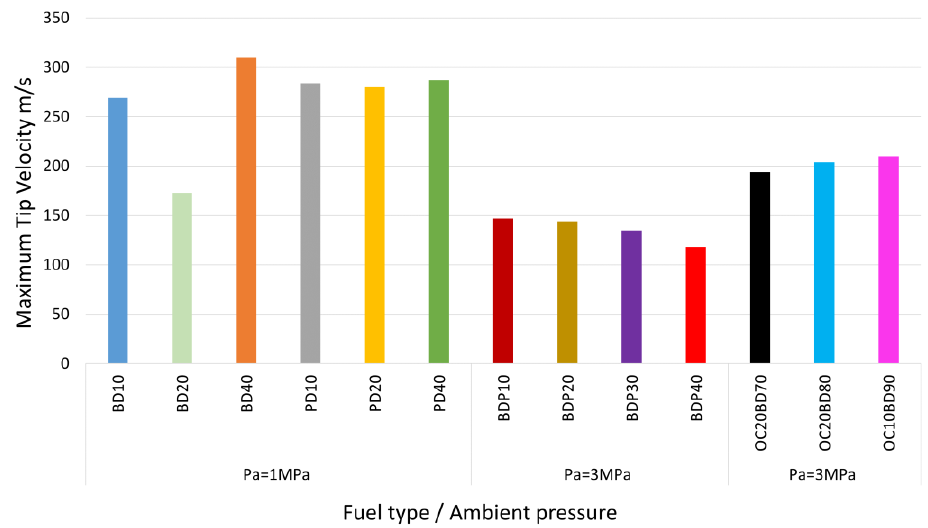
Figure 6. Maximum spray tip velocity for butanol, pentanol, and octanol with diesel at 100 MPa injection pressure and three different ambient pressures [19,51,55].